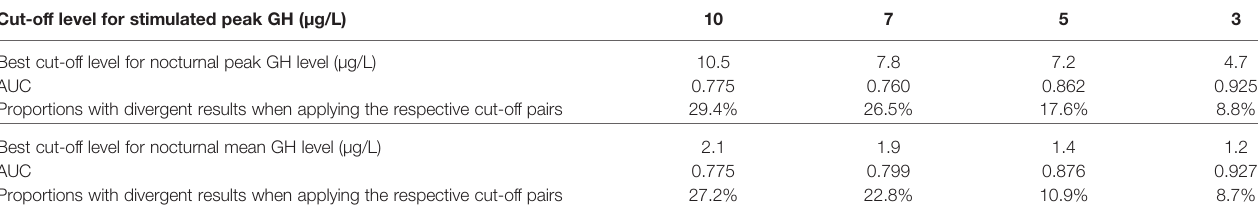
AUC, area under the curve. GH, growth hormone. ROC, receiver operating